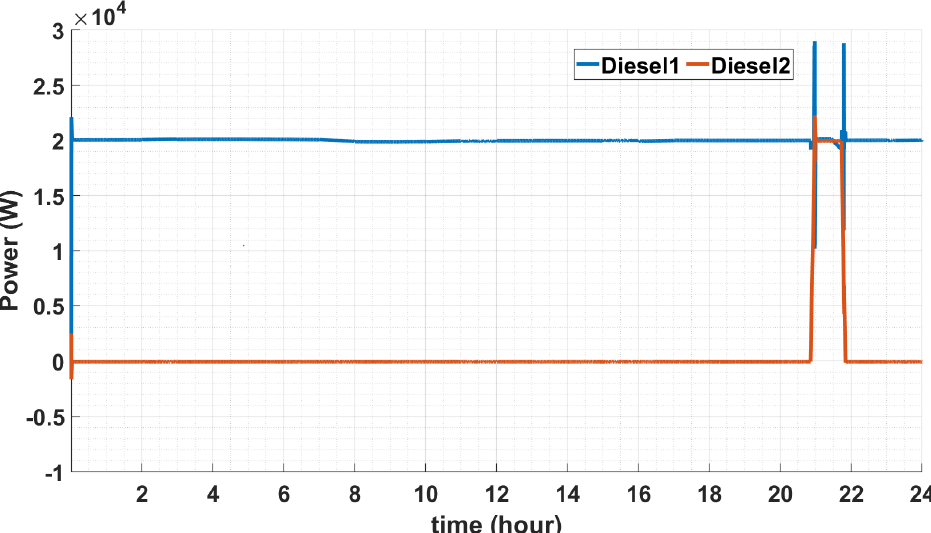
Figure 16. Active power of the DG1 and the DG2.